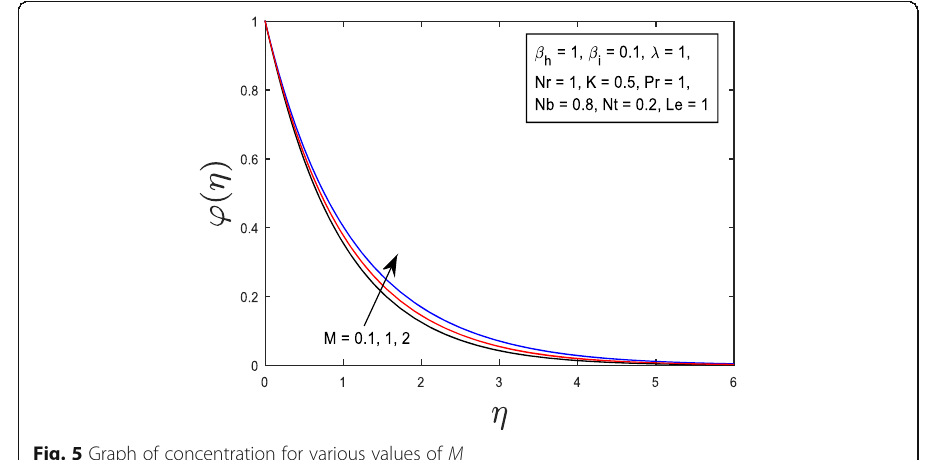
Fig. 5 Graph of concentration for various values of M